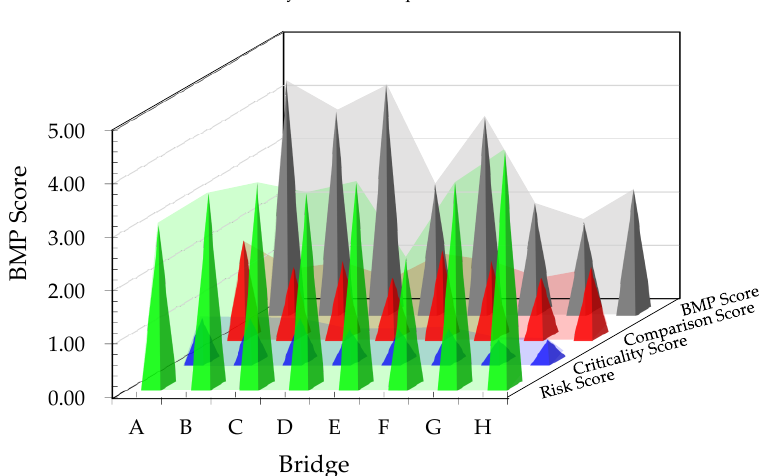
Figure 5. Distribution by factors according to BMP score results. Table 7. Maintenance priority selection